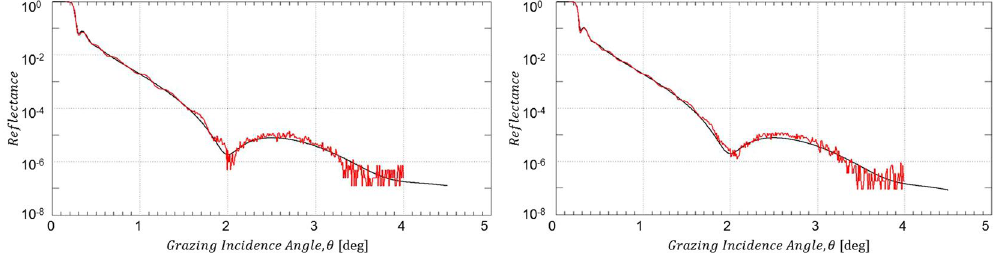
Figure 6. XRR data from B 4 C-coated test mirror right after H 2 /Ar plasma cleaning. Left hand side: Non a-C coated part; right hand side: Formerly a-C coated part (red solid lines: experimental XRR data; black solid lines: IMD simulation).